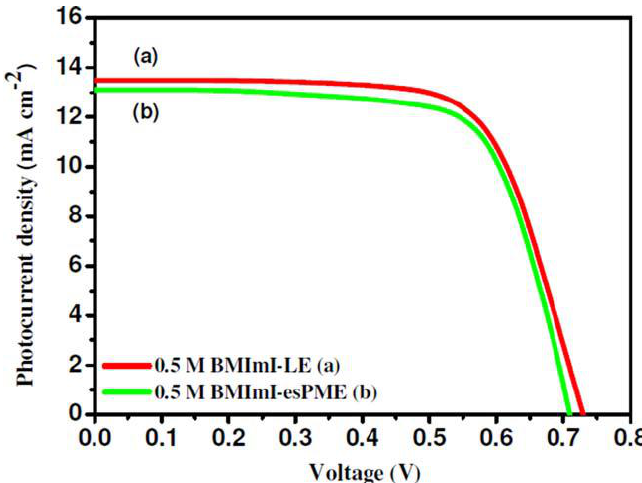
Figure 8. Photocurrent density-voltage (J-V) curves for the DSSC containing ( a ) 0.5 M 1-butyl-3- methylimidazolium iodide (BMImI)-LE and ( b ) 0.5 M BMImI-esPME. Reproduced with permission from [209] . Copyright Wiley, 2015. Table 5. Photovoltaic performance of the DSSCs based on electrospun fibers.